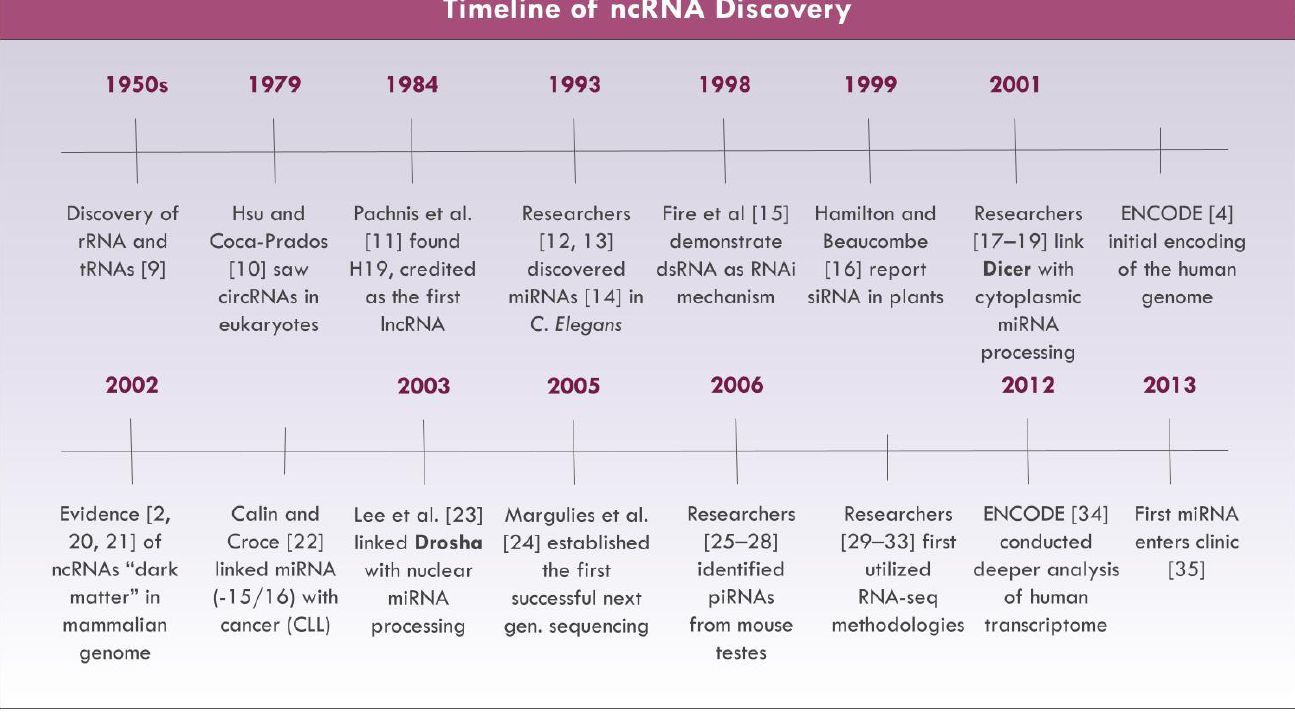
Figure 1. Non-coding RNA (ncRNA) research milestones [2,4,9–35] .